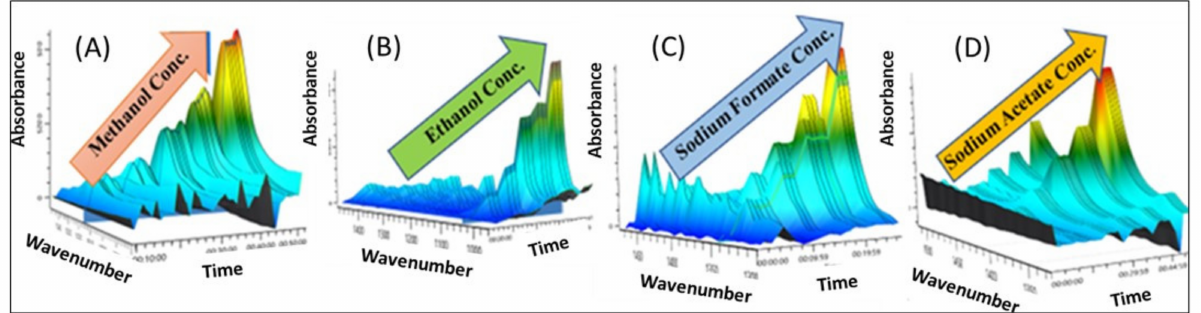
Figure 2. ATR-FTIR spectra at increasing concentrations ( A ) methanol, 1018 cm − 1 , ( B ) ethanol, 1044 cm − 1 , ( C ) sodium formate 1350 cm − 1 , and ( D ) sodium acetate 1414 cm − 1 . Spectra are zoomed in for